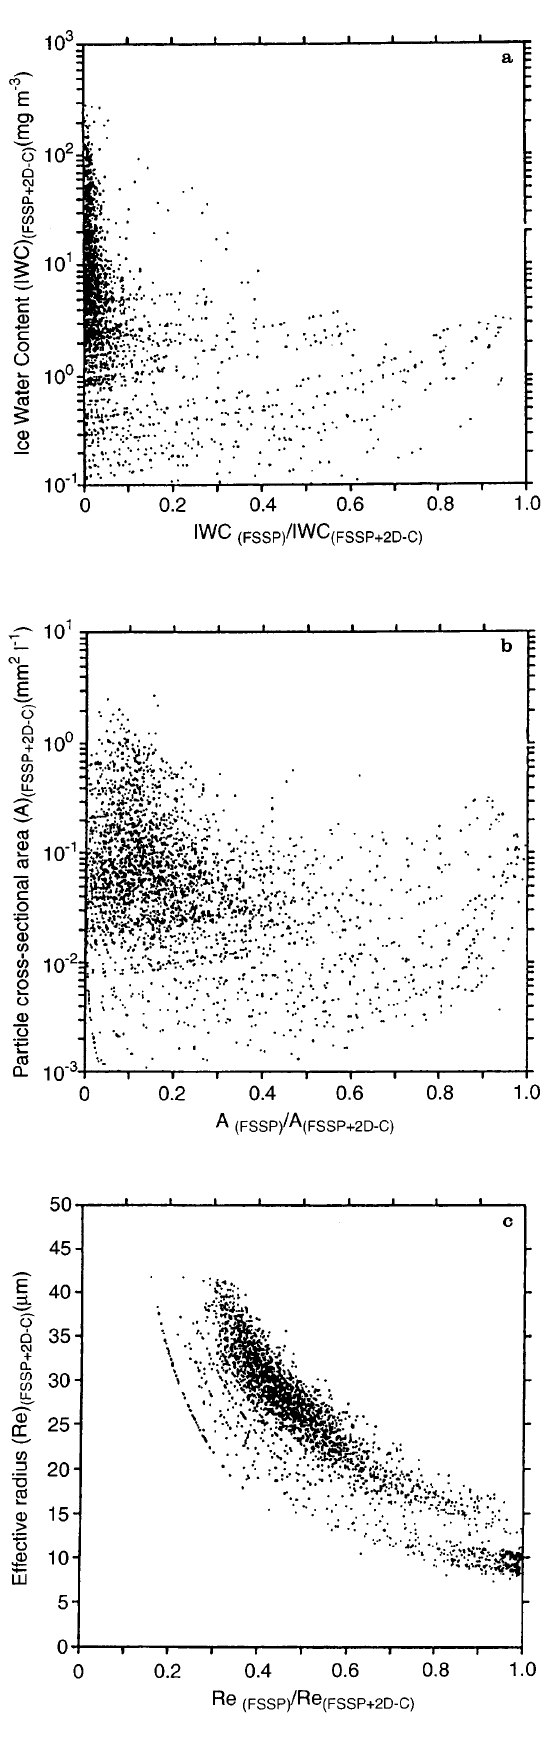
contributed by e